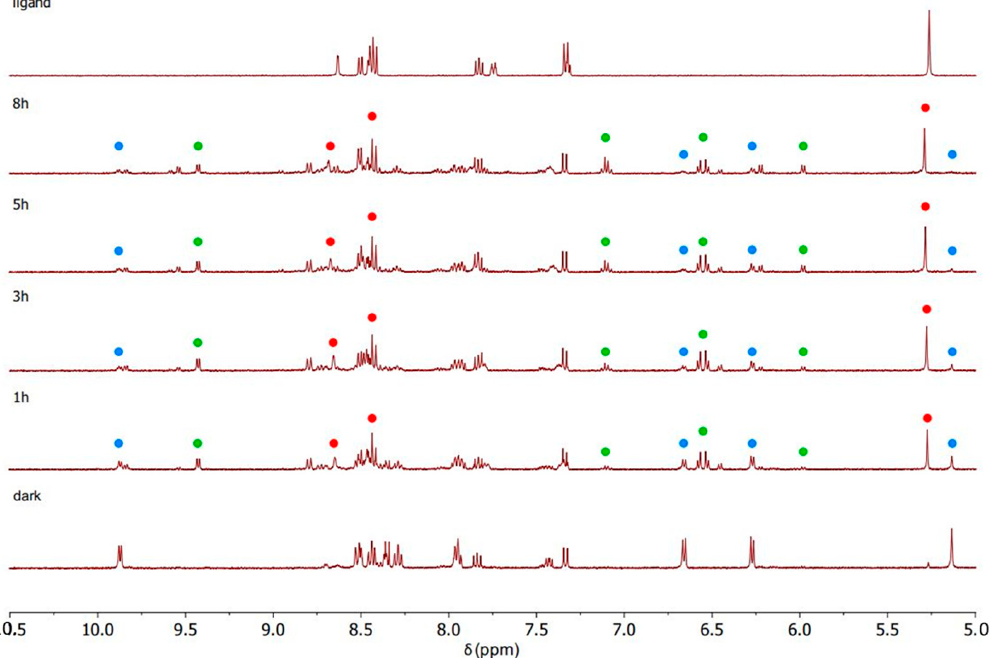
Figure 7. 1 H NMR spectra recorded during the photoactivation of complex C3 with blue light (420 nm) in DMSO-d 6 .